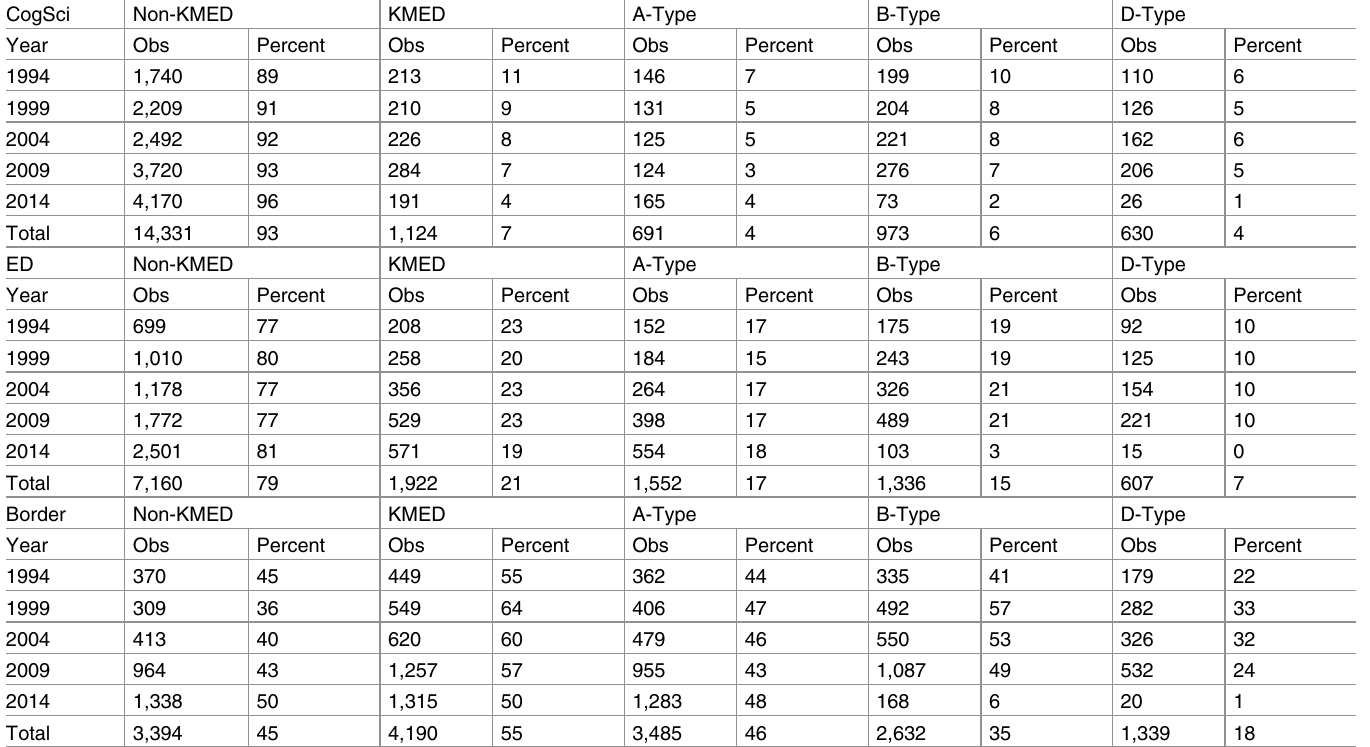
Table 1. Number of articles in CogSci, ED, and border journals, by KMED type and